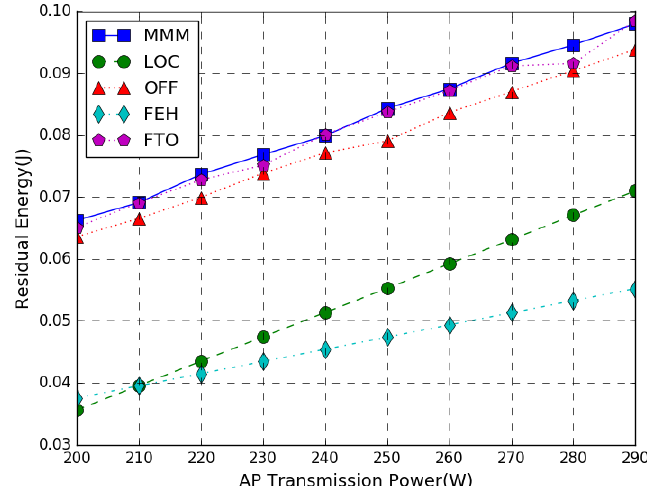
Figure 3. Access point (AP) transmission power vs. residual